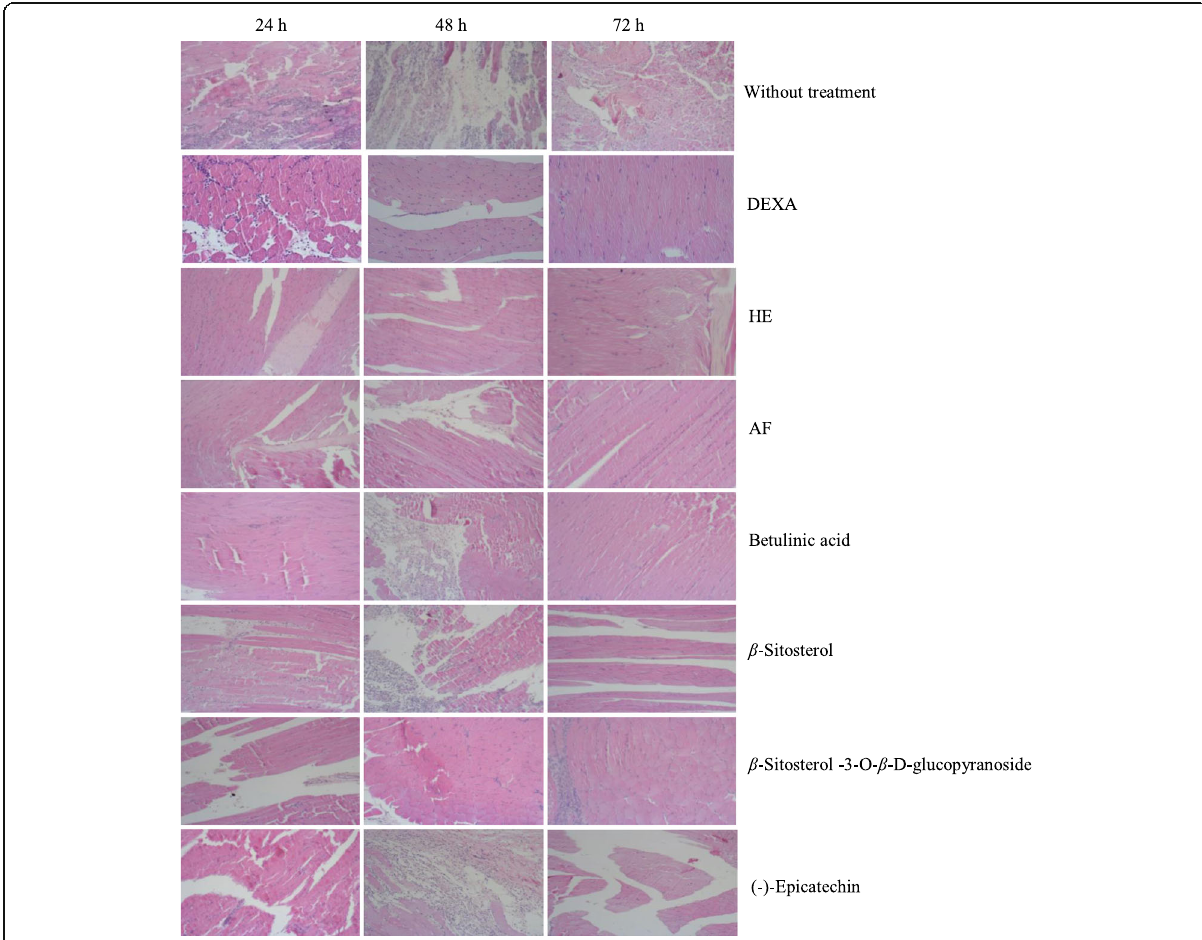
Fig. 2 Histological aspect of the injured muscles of rat paws without treatment and treated for 24, 48, and 72 h with the application of gels with dexamethasone, hexane extract (HE), ethyl acetate fraction (AF), betulinic acid, β -sitosterol, β -sitosterol-3-O- β -D-glucopyranoside,